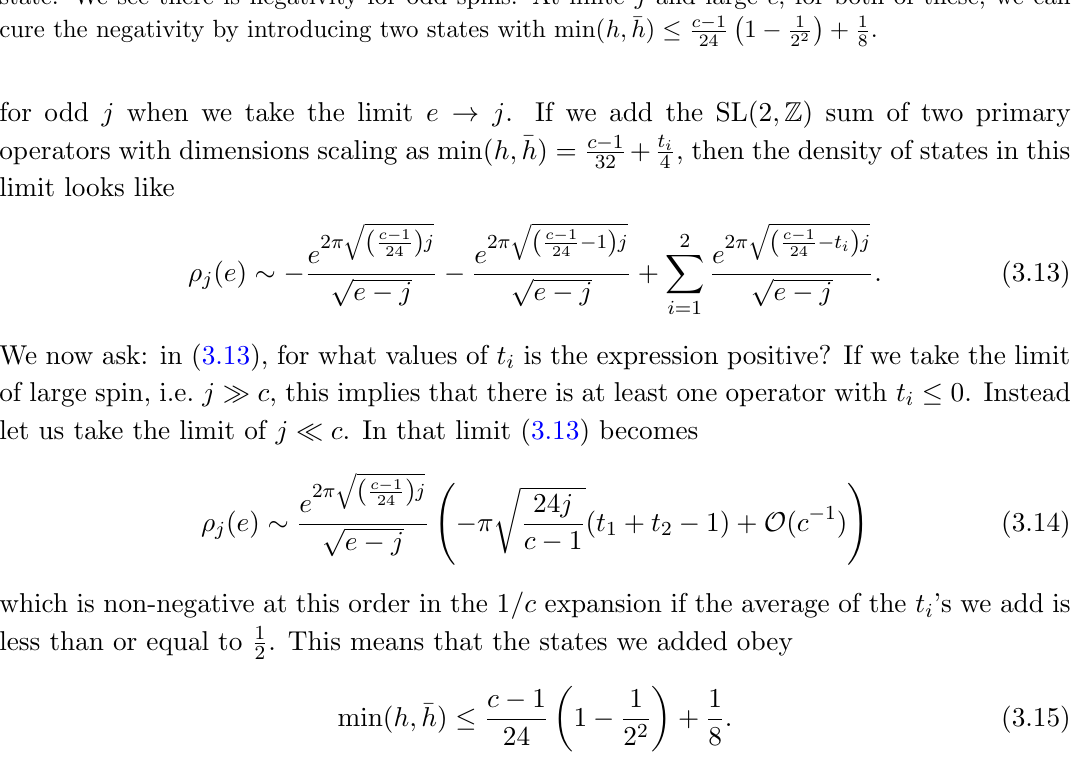
(cid:0) (cid:1) 1 (cid:0) 1 + 1 24 2 2 8